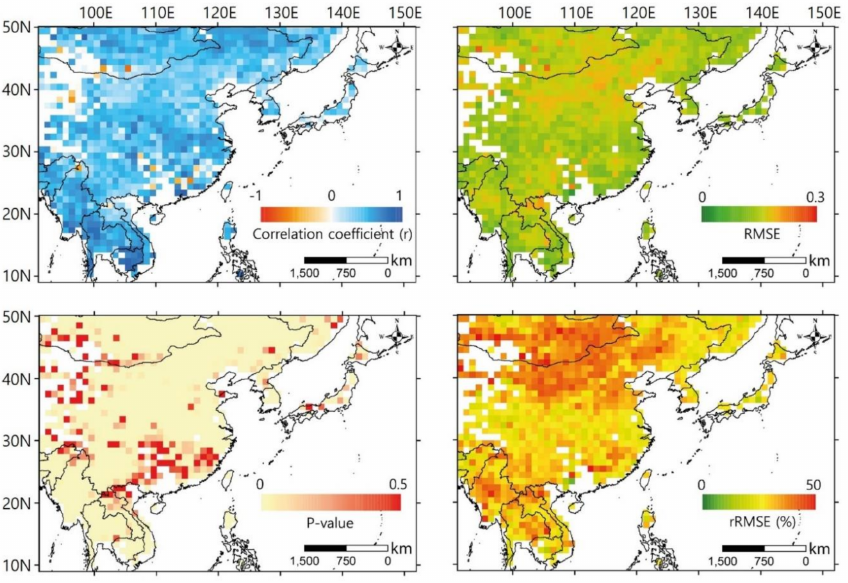
Figure 6. ‘Leave-one-year-out’ validation of VSDI prediction model. Each pixel includes 9 pentads ×